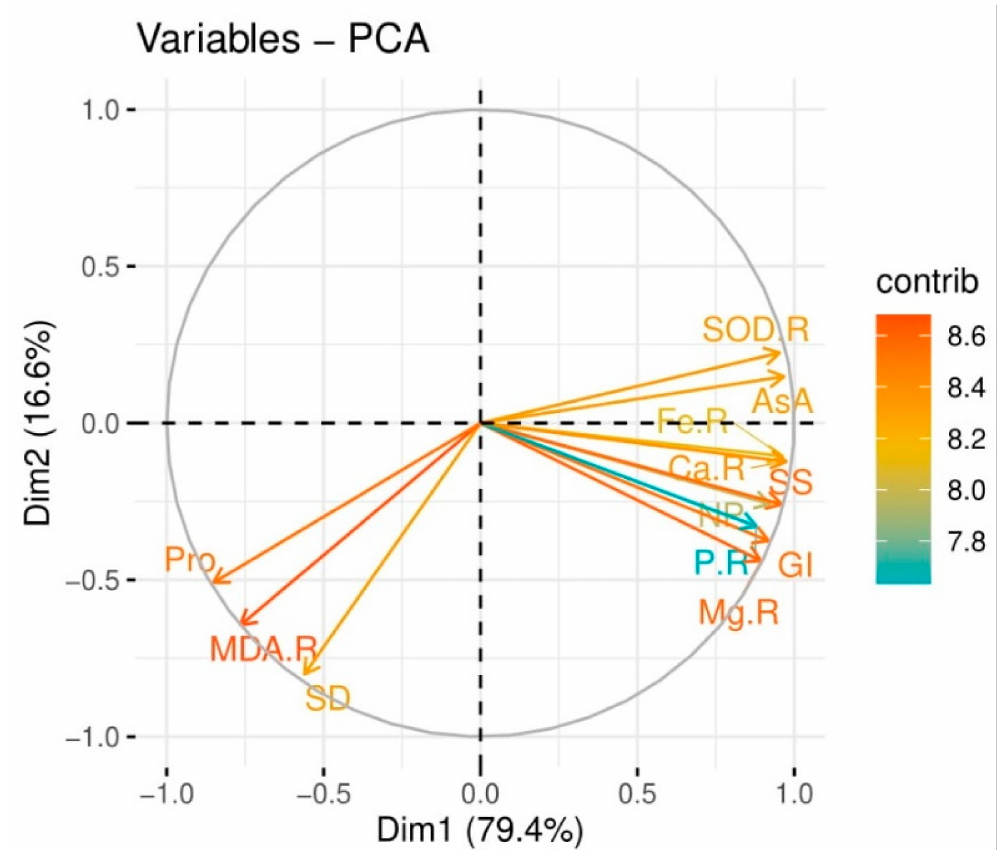
Figure 11. Loading plots of principal component analysis (PCA) on different studied attributes of Zea mays grown under water stressed and non-stressed environments with various application levels of Plantago ovata leaf extract. Different abbre- viations used are as follow: Ca-R (calcium contents in the roots), Fe-R (iron contents in the roots), P-R (phosphorus contents in the roots), Mg-R (magnesium contents in the roots), SS (soluble sugar), AsA (ascorbic acid contents), SOD-R (su- peroxidase dismutase activity in the roots), NP (net photosynthesis), GI (germination index), Pro (proline contents), SD (stomatal density) and MDA-R (malondialdehyde contents in the